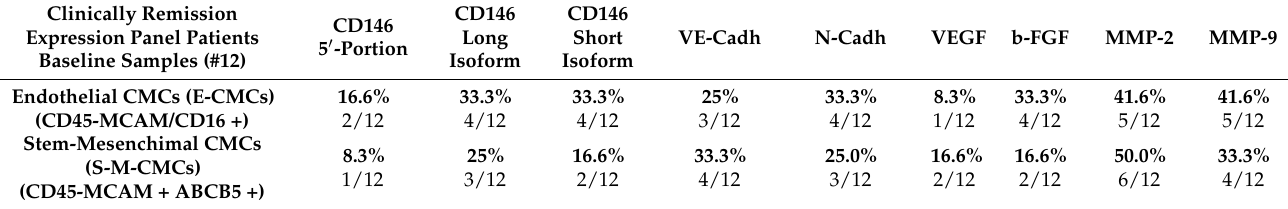
Table 2. (A) Molecular expression (percentage) of proangiogenic markers, cell–cell adhesion factors, and matrix metallo- proteinases in the two enriched CMC subpopulations from melanoma patients collected at disease onset or first clinical observation (baseline) and soluble CD146 (sCD146) serum dosages are reported here in two classes of patients distinguished by their clinical